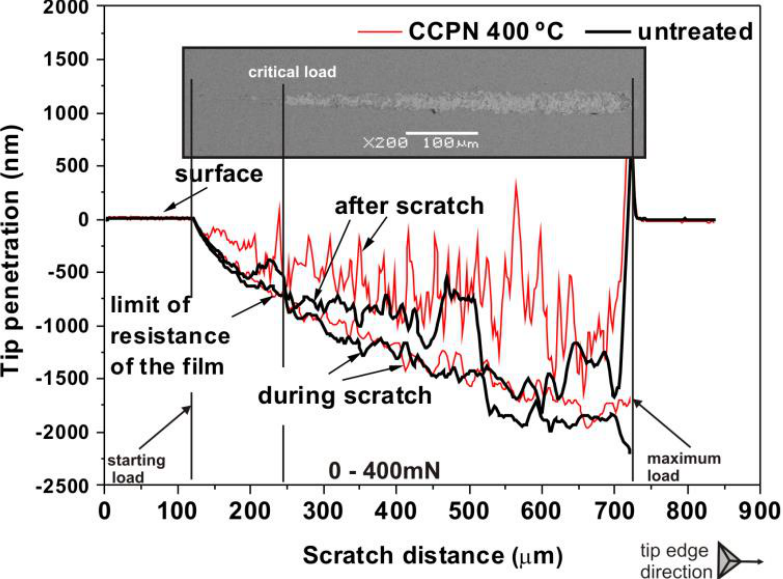
Figure 16. Profile graph and nanoscratch micrograph obtained by backscattered SEM of the AISI 316 steel sample treated at 400 °C for 6 h by CCPN.